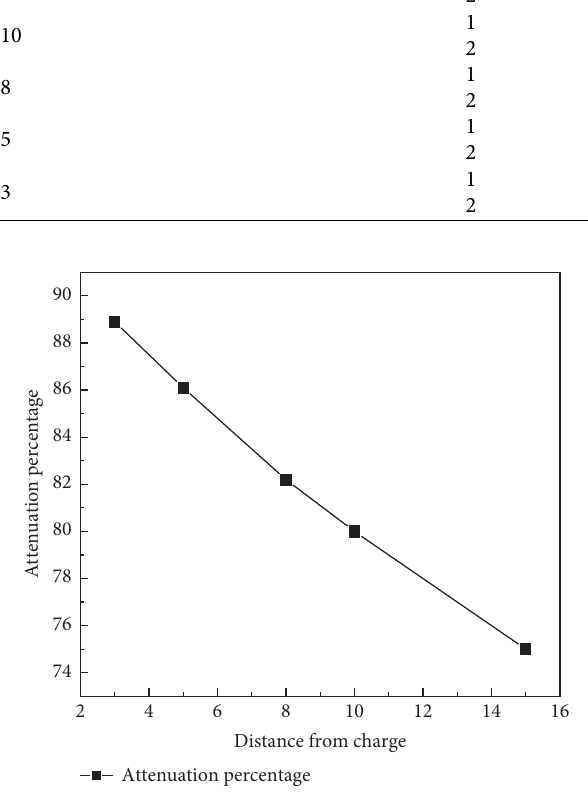
Figure 12: Attenuation percentage diagram of different distance between bubble curtain and